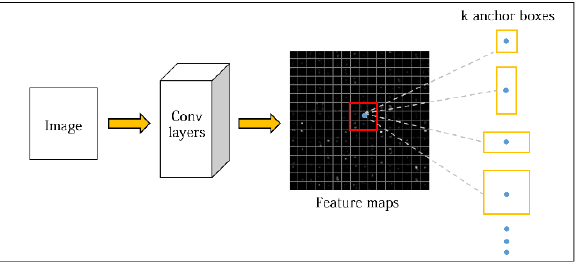
Figure 4. Illustration a process of region proposal network.